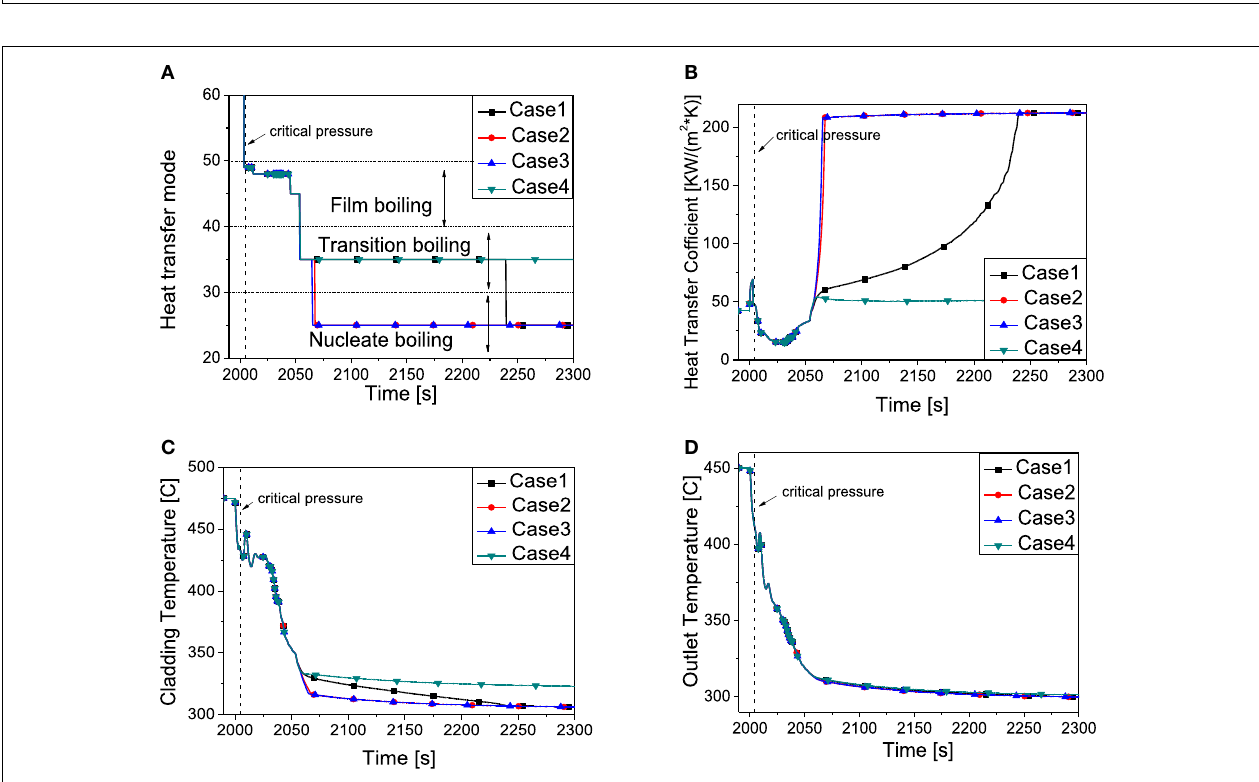
FIGURE 13 | System behavior by the effect of HTC for CHF . (A) Heat transfer mode. (B) Heat transfer coefficient. (C) Peaking cladding temperature. (D) Core outlet temperature.